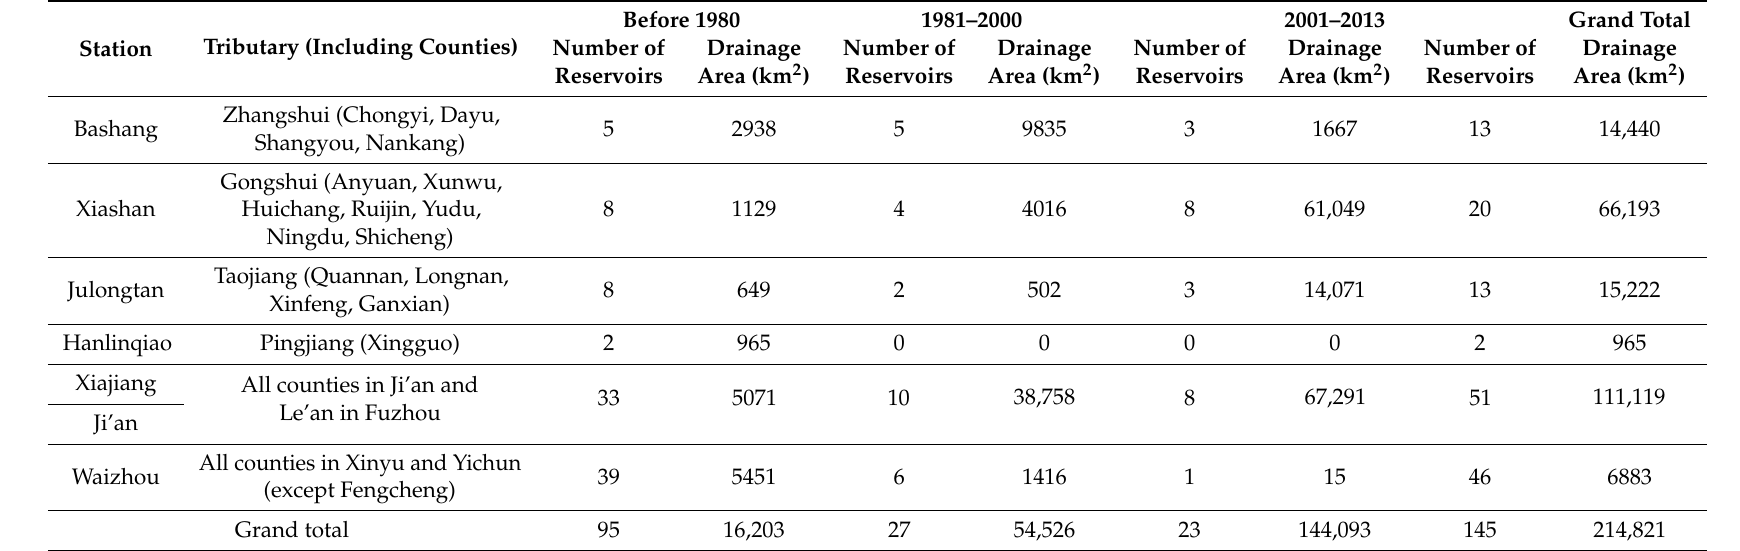
Table 7. Characteristics of large and medium-sized reservoirs constructed in the past decades in the Ganjiang River